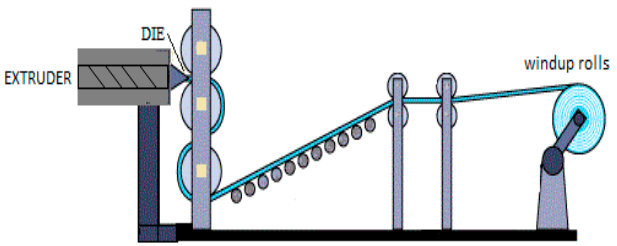
Figure 3. Schematic diagram of the flat die extrusion.